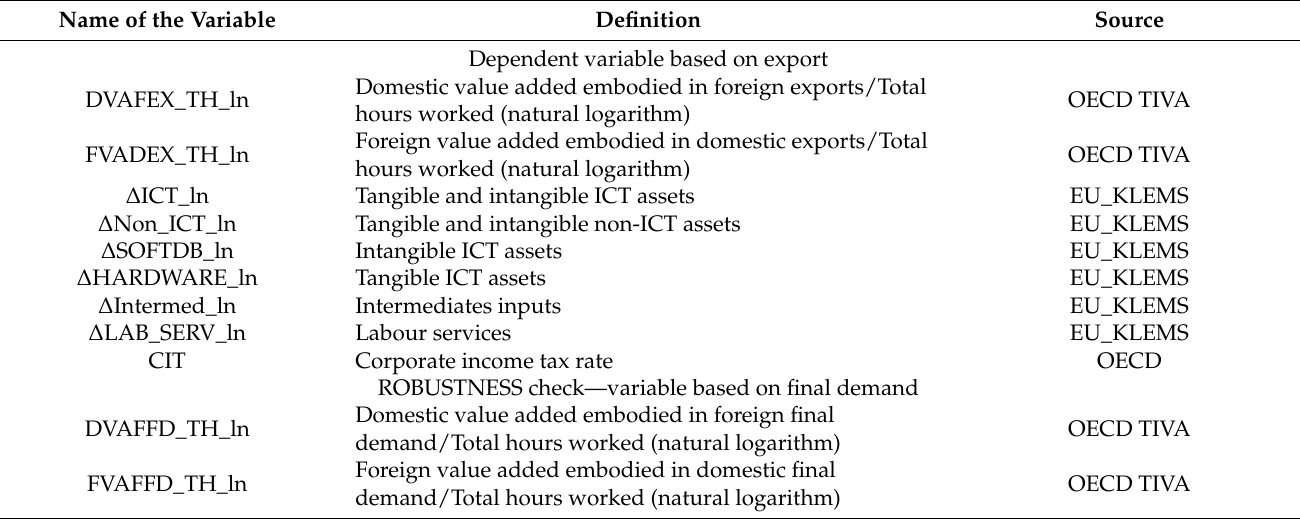
Table 1. Definition of variables used in econometric